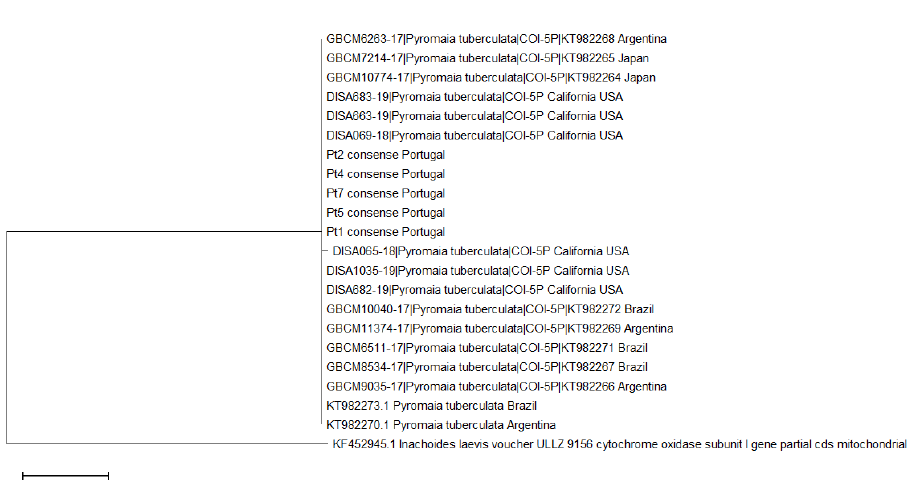
Figure 3. Maximum likelihood tree, generated from COI-5P sequences of Pyromaia tuberculata from Argentina, Brazil, California (USA), Japan, and Portugal. 1000 bootstrap replications were applied. Data coverage of the node is 82%. Scale bar represents 0.02 substitutions per site.